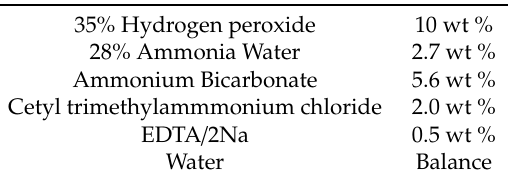
Table 1. Formulation of bleaching lotion (pH 9.0).